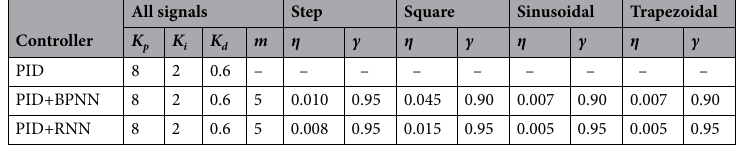
Table 2. The optimal parameters of the different controllers in the simulation tests.